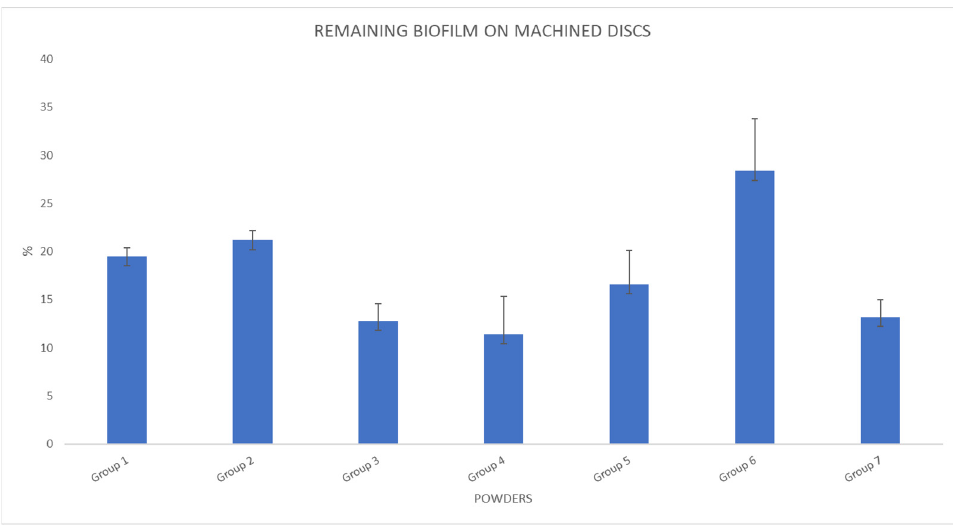
Figure 3. Percentage of remaining biofilm after decontamination of titanium discs with machined surface (M) by means of air abrasive unit delivering different powders.